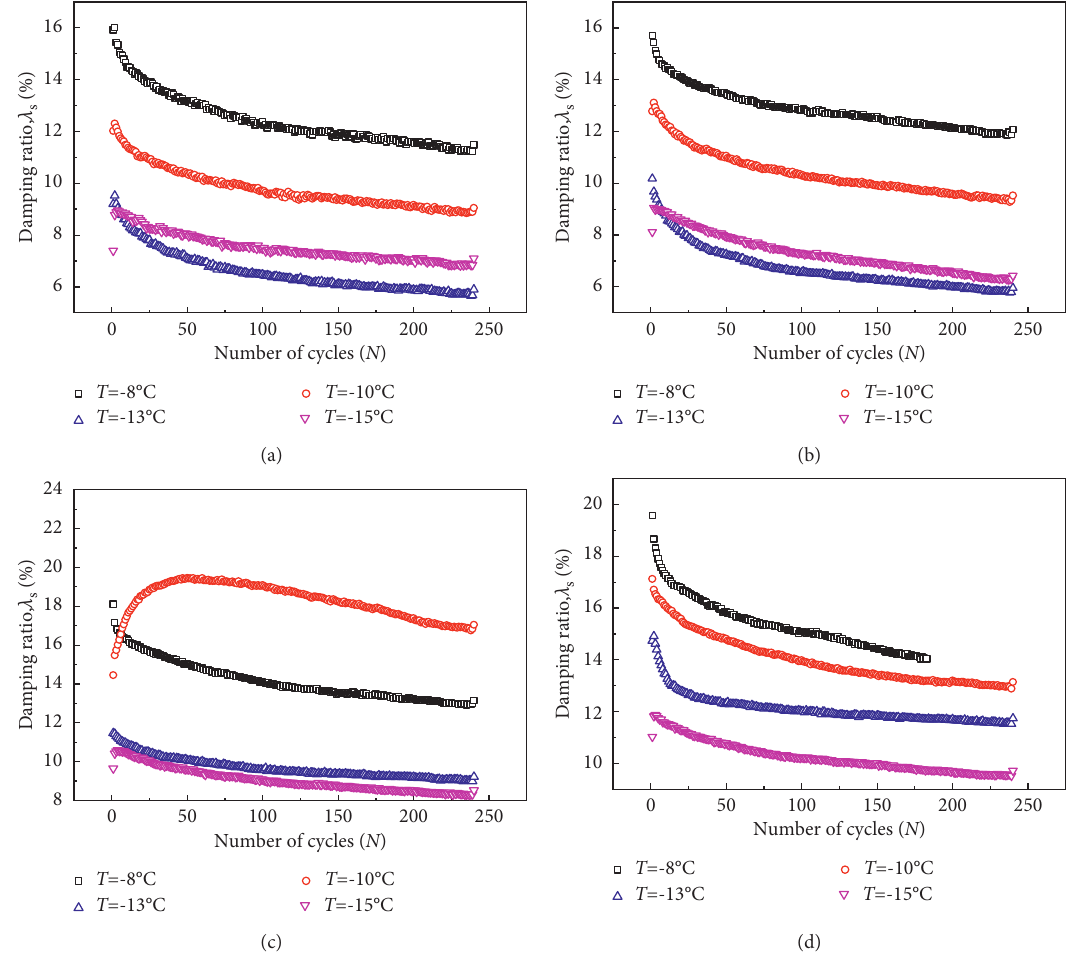
Figure 16: The evolution of the torsional damping ratio versus the number of cycles under different temperatures and CSRs. (a)